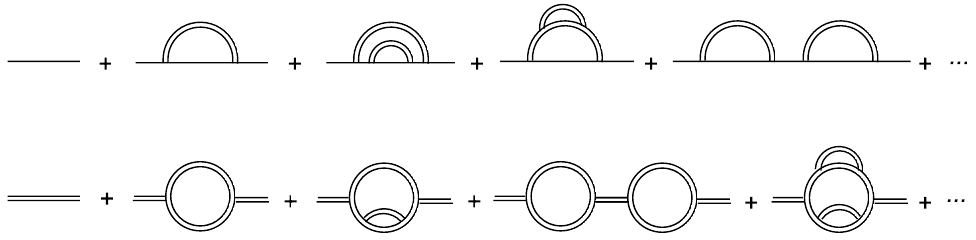
Figure 4 . The (cid:12)rst few diagrams which dominate the (top panel) and (cid:31)(cid:31) (bottom panel) 2-point functions (and their super-descendants) in the large- n limit when g (cid:24) 1 =n . In each panel the (cid:12)ve diagrams scale as g k n k for k = 0 ; 2 ; 4 ; 4 ; 4, respectively. As noted in the text, single lines represent a or (cid:12) a (cid:12)elds and double lines represent the mesonic (cid:31) ab or (cid:25) ab (cid:12)elds. All dominant diagrams are obtained by iterating the building blocks shown in (cid:12)gure